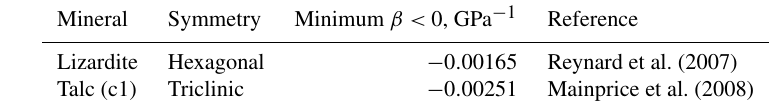
Table 3. List of rock-forming minerals showing negative linear compressibility (NLC) in at least one direction.